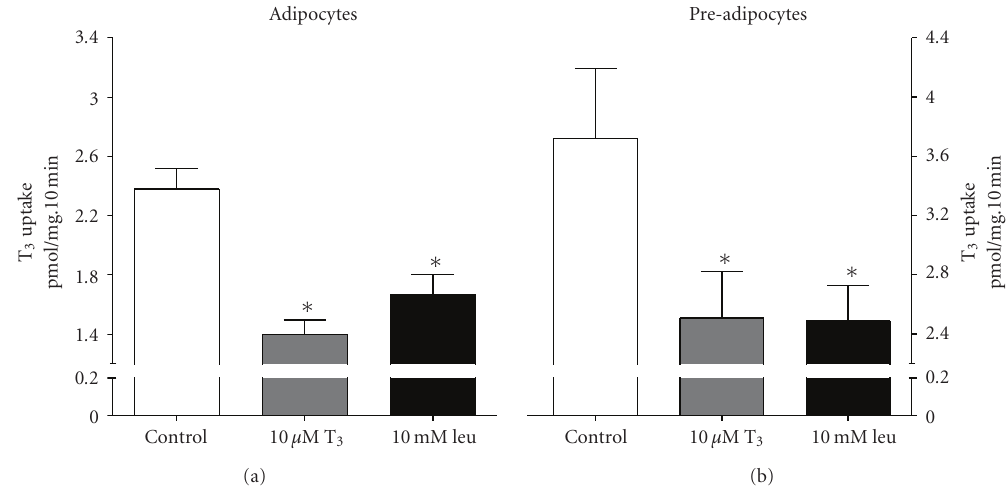
Figure 1: Uptake of the iodothyronine L-T 3 into 3T3-L1 adipocytes and pre-adipocytes. [ 125 I]-T 3 uptake was measured at 50 nM over 10 minutes in the absence (control) or presence of 10 μ M unlabelled T 3 or 10 mM leucine in the uptake bu ff er. Values are expressed ± SEM of 6–12 measurements. ∗ P < . 05; value significantly di ff erent from control using Dunnett’s Multiple Comparison Test.